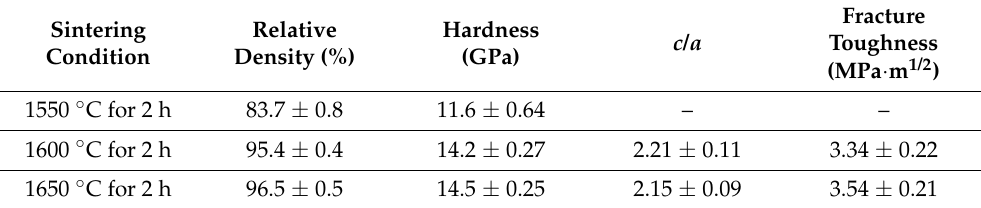
Table 2. Properties of sintered Al 2 O 3 –YAG samples obtained by DIW. Relative Density Sintering Condition